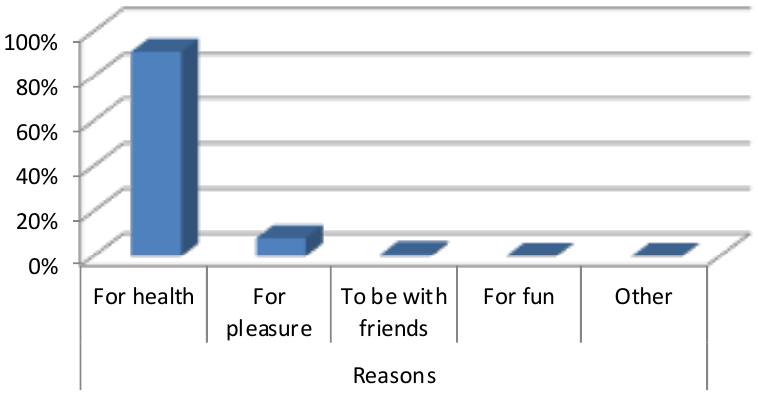
Figure 1. Motivation for physical activity of elderly (Own production). Table 1. Materials preferred by the elderly according to their characteristics (Own production).